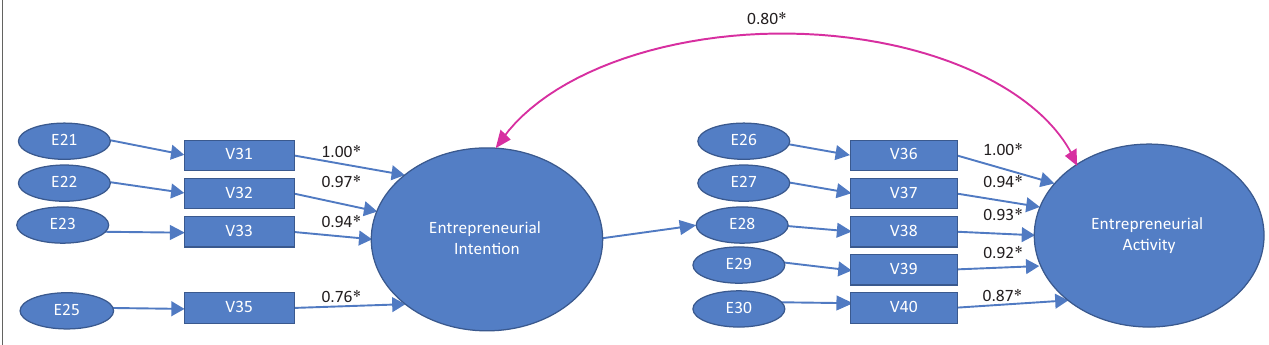
Entrepreneurial Inten(cid:19)on